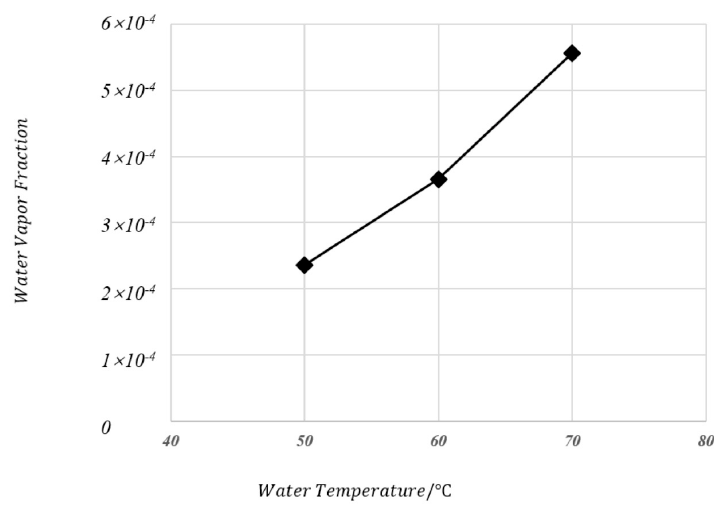
Figure 5. Water vapor mass fraction and relative humidity at the outlet of humidifier at different temperatures: ( a ) The temperature is 50 ℃ ; ( b ) the temperature is 60 ℃ ; ( c ) the temperature is 70 ℃ .